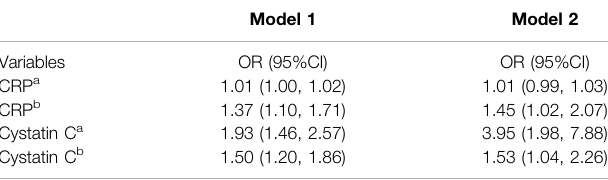
TABLE 4| Logistic regressionanalysesofassociationsbetweenclinicalmeasures and MCR. Model 1 Model